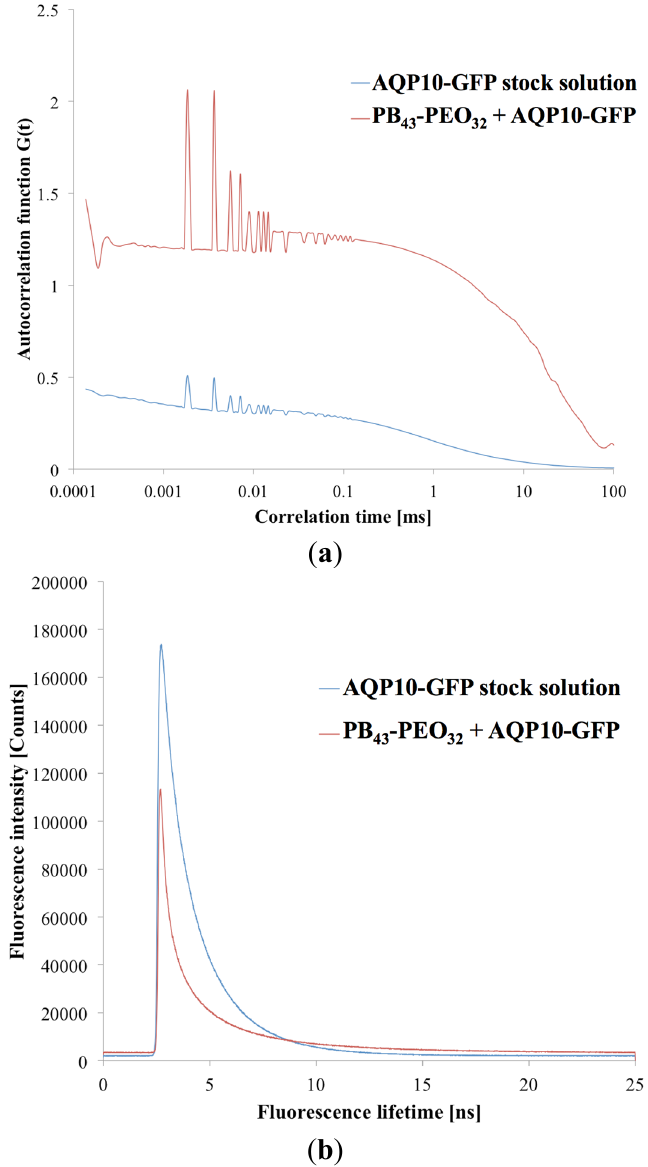
Figure 6. ( a ) Correlation diagram of proteopolymersomes and AQP10-GFP stock solution as a function of correlation time τ against autocorrelation function G( τ ). The higher autocorrelation signal indicates a lower number of particles in the confocal volume, due to slower diffusion time. ( b ) Fluorescence lifetimes of the same samples as a function of lifetime against intensity signal. Where the intensities varied, the fluorescence lifetime was in a comparable